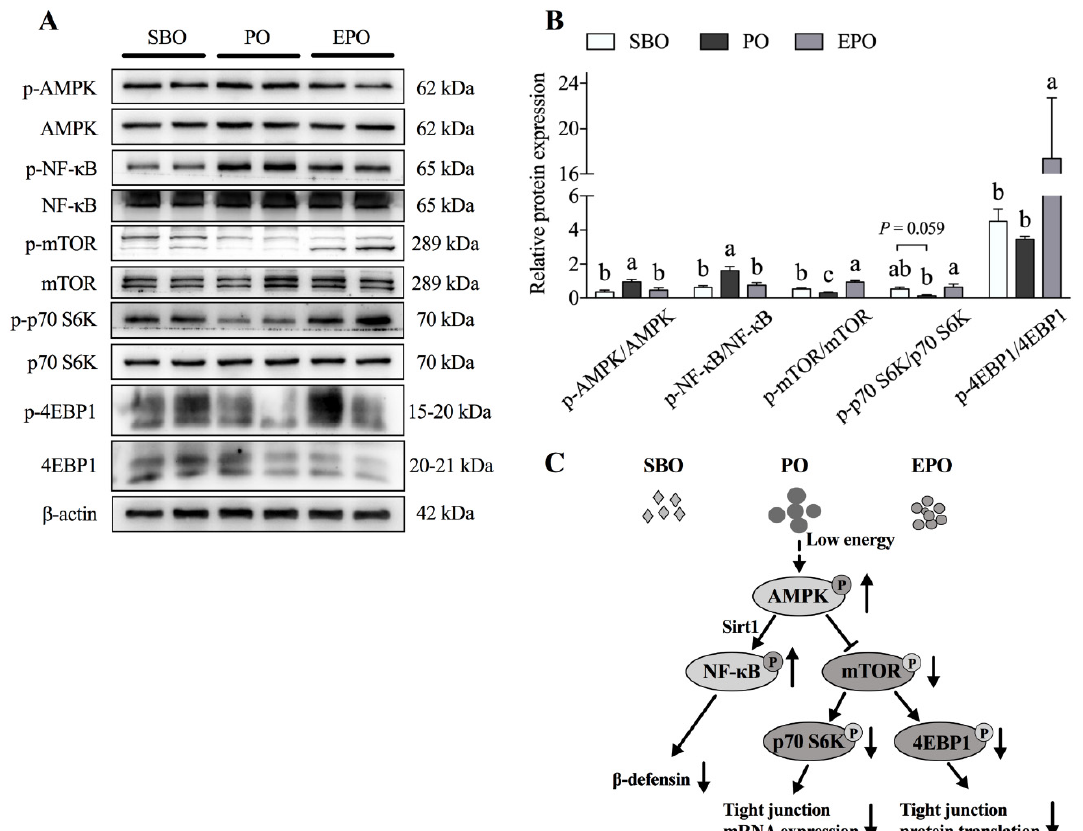
Figure 4. AMPK/mTORC1 and AMPK/Sirt1/NF ‐κ B pathways in the jejunum. ( A , B ) The levels of phosphorylated proteins in the AMPK/mTORC1 and the AMPK/Sirt1/NF ‐κ B pathways in the jejunum. ( C ) The energy produced by lipid metabolism regulates the pig intestinal barrier through the AMPK/mTORC1 and AMPK/Sirt1/NF ‐κ B pathways. SBO, soybean oil group; PO, palm oil group; EPO, encapsulated palm oil group. Different letters (a, b, and c) indicate a significant difference among different groups ( p < 0.05).